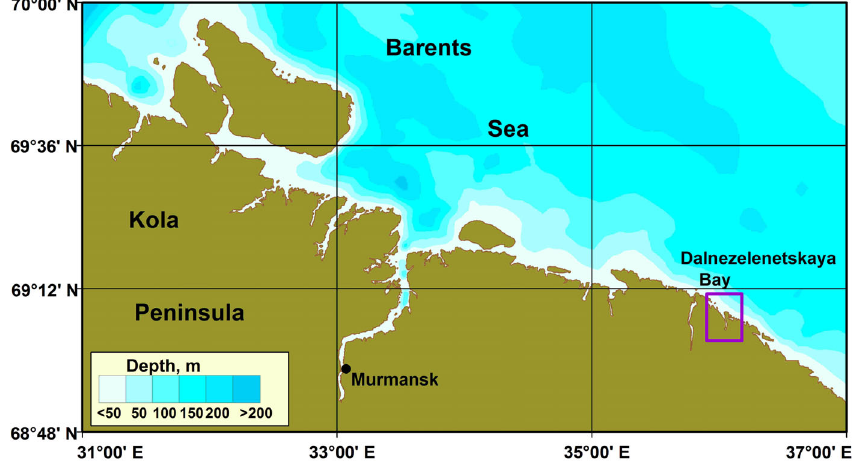
Figure 1. Location for the sampling (square) of the red king crab in the southern Barents Sea.